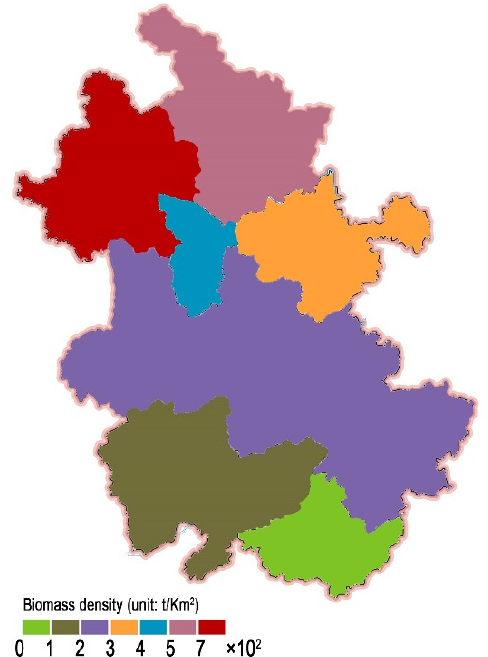
Figure 5. The biomass density in AHP (unit: t / Km 2